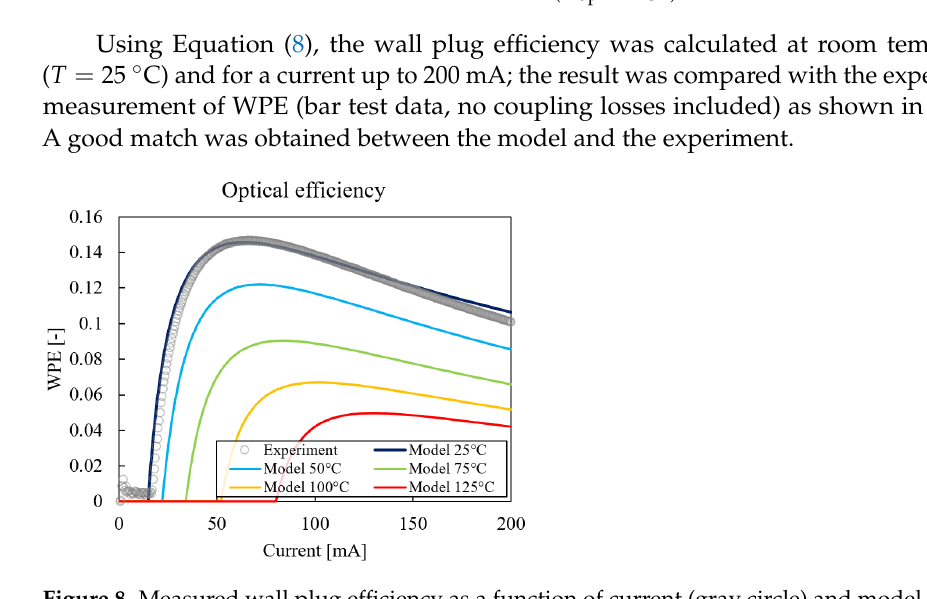
Figure 8. Measured wall plug efficiency as a function of current (gray circle) and model fit (black). Model extrapolation up to T = 125 ◦